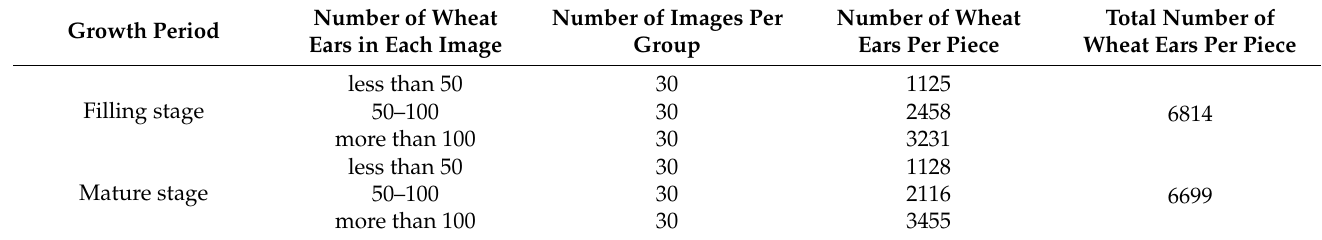
Table 3. Testing Table 2. Training database.